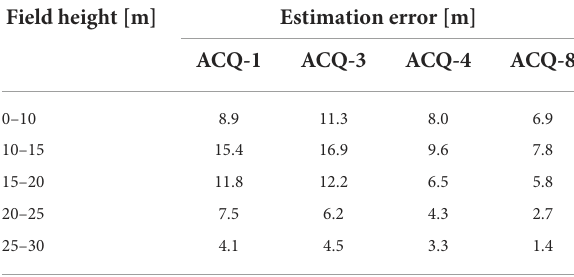
TABLE 4 Comparison of estimation error for different field height ranges for acquisitions 1, 3, 4, and 8. Field height